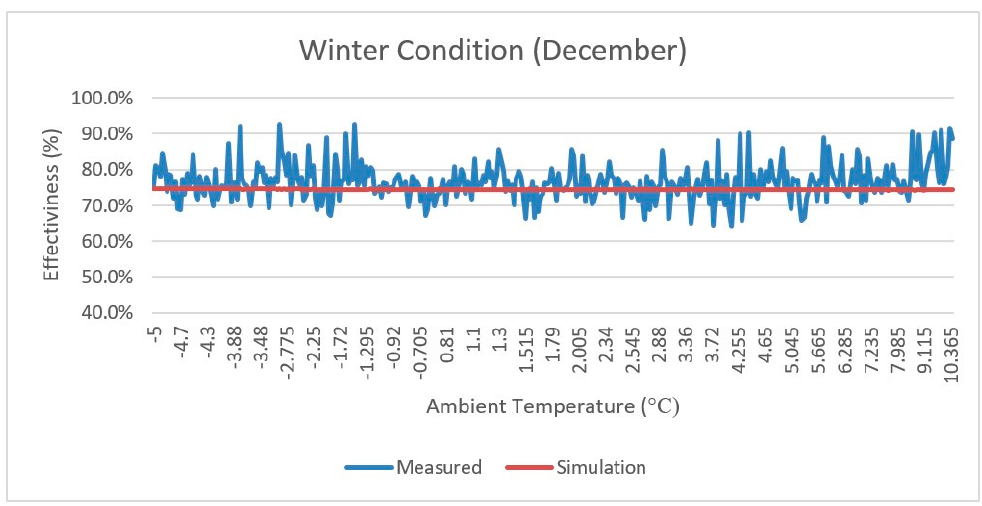
Figure 9. The measured and simulated sensible effectiveness values in summer.